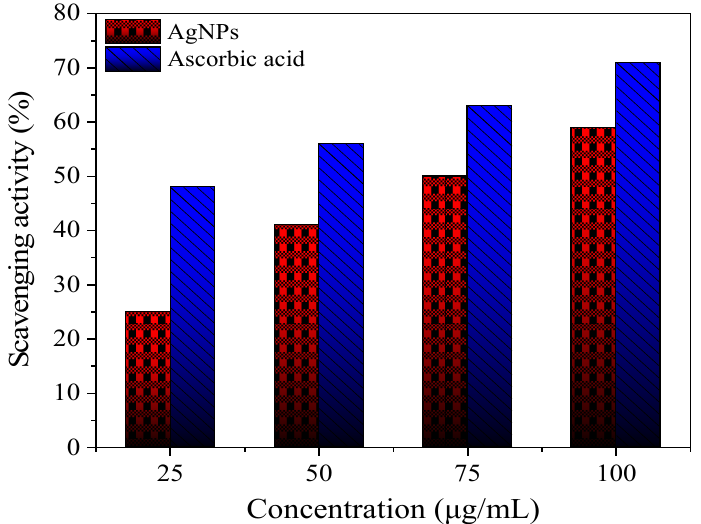
Figure 4. DPPH free radical scavenging activity (%) of St-AgNPs compared to ascorbic